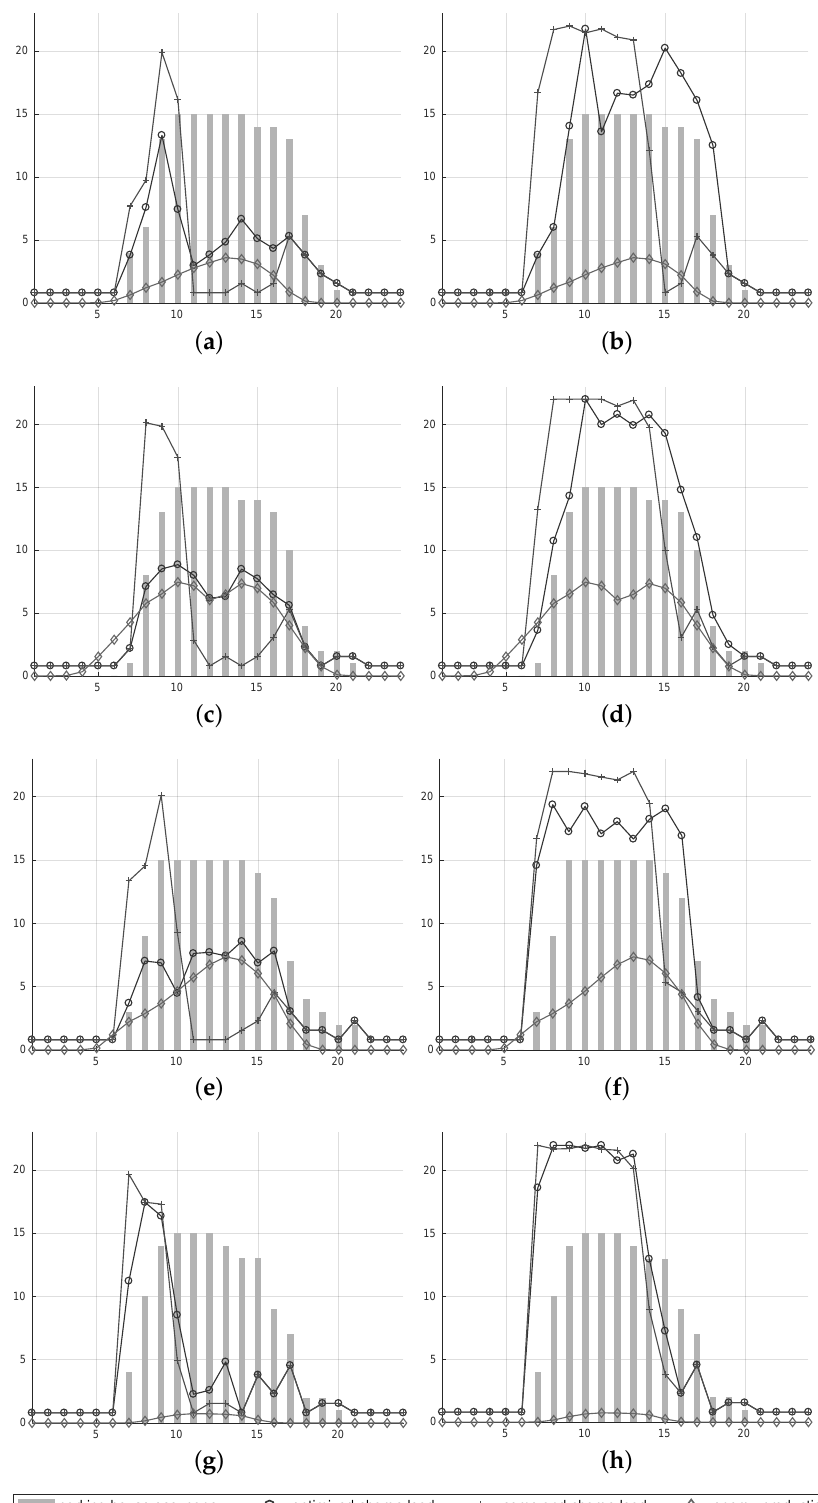
Figure 6. The comparisons of optimized loads vs. come’n charge loads on four different months (( a , b ) March, ( c , d ) June, ( e , f ) September and ( g , h ) December) and both consumption modes (( a , c , e , f ) reflect consumption lowered by the current battery state while ( b , d , f , h ) are not taking this into account). In all figures, the horizontal axis represents time in hours (1 day) and vertical axis means the absolute values of depicted measures (number of cars and kW ·